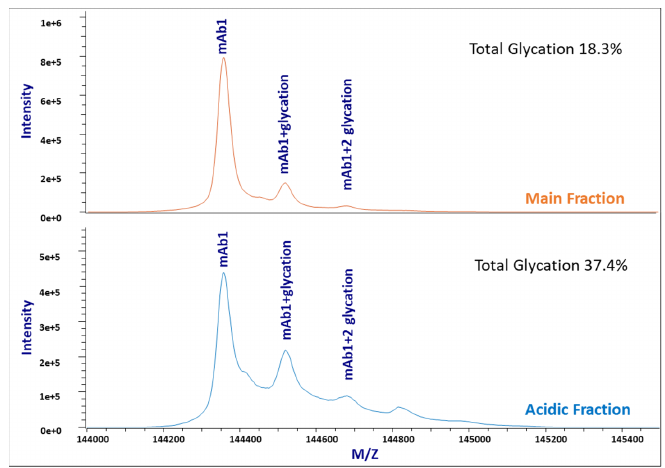
Figure 6. Stacked intact mass analysis TIC plots of the mAb1 main fraction ( top ) and the acidic fraction ( bottom ), showing different glycation levels.